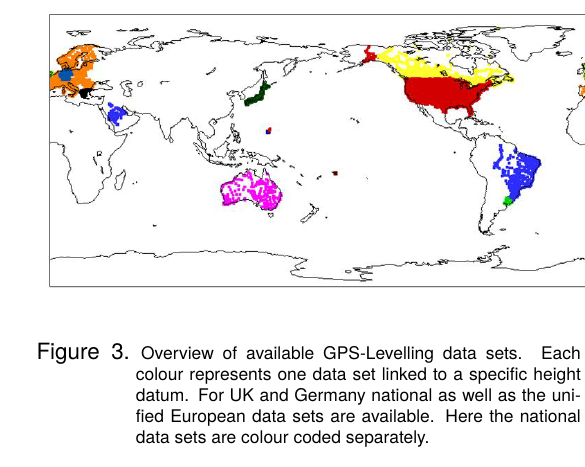
Figure 3. Overview of available GPS-Levelling data sets. Each colour represents one data set linked to a specific height datum. For UK and Germany national as well as the uni- fied European data sets are available. Here the national data sets are colour coded